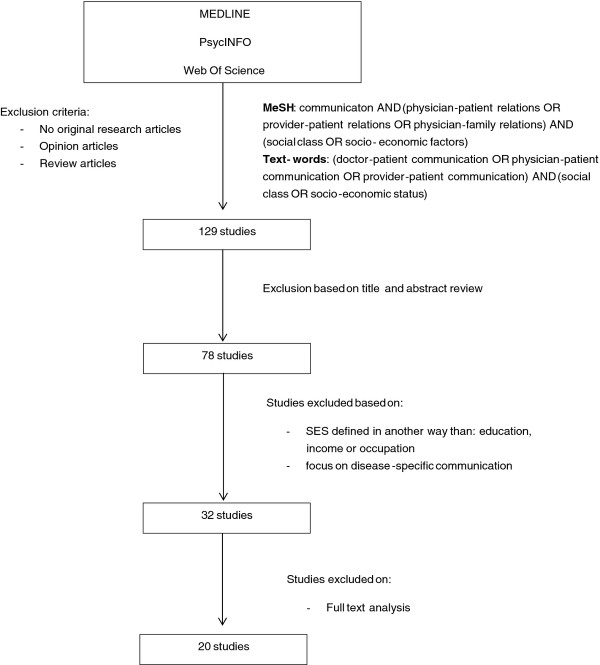
Selection procedure.